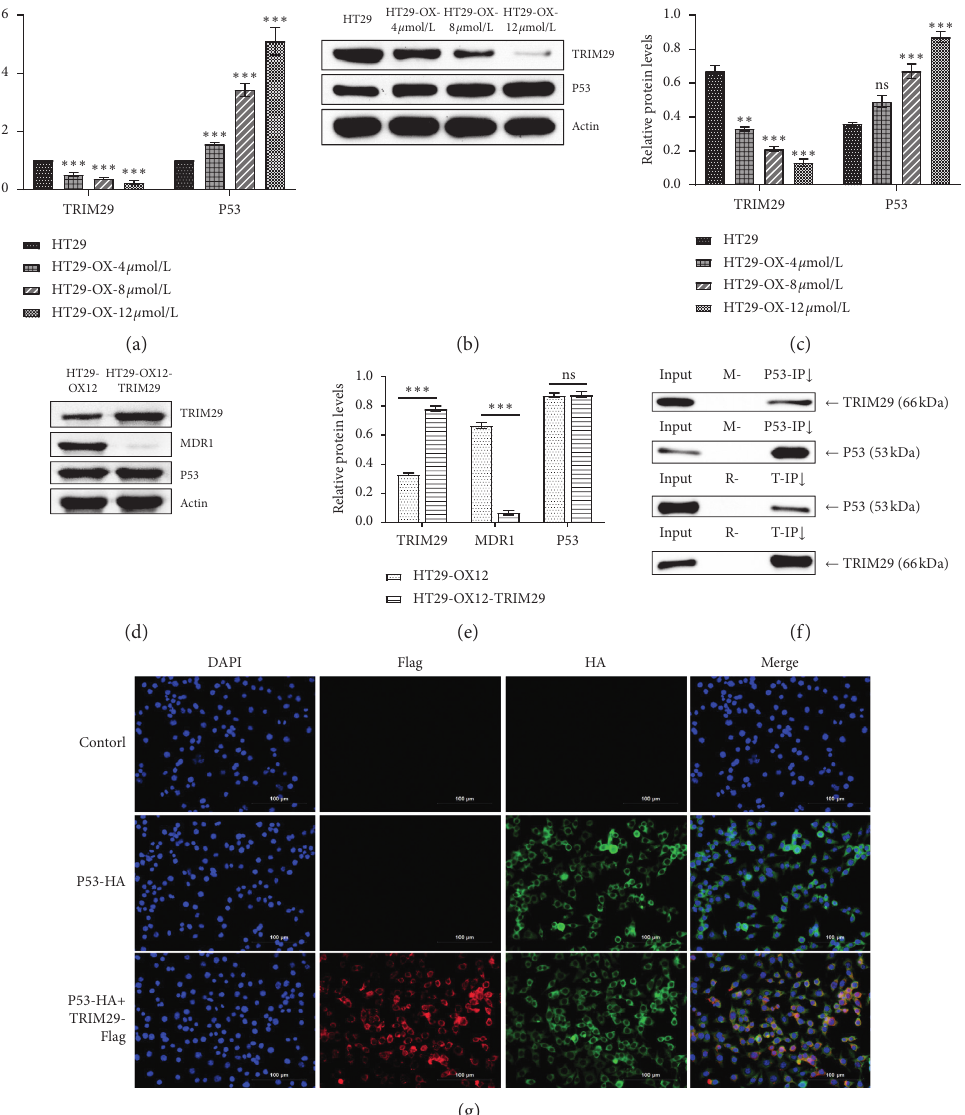
Figure 4: TRIM29 physically binds with mutant P53. (a) qRT-PCR was used to detect the expression of TRIM29 and P53 in the three drug- resistant cell models with the increase of drug resistance concentration. After the HT29-OX-12 μ mol/L cells were transfected with pIRES2- ZsGreen1-TRIM29-flag plasmid, the changes of P53 and MDR1 expression were detected. (b) The Western blot method was used to detect the expression of TRIM29 and P53 in the three drug-resistant cell models. (c) The quantitative analysis of (b). (d) After the HT29-OX- 12 μ mol/L cells were transfected with pIRES2-ZsGreen1-TRIM29-flag plasmid, the protein expression changes of P53 and MDR1 expression were detected. (e) Quantitative analysis of (d). (f) Coimmunoprecipitation method was used to detect the interaction between TRIM29 and mutant P53 protein in HT29 cells. (g) Immunofluorescence detection of the interaction between TRIM29 and mutant P53 protein in HT29 cells. Scale bar � 100 μ m. The magnification is 400 times; ns: not significant; ∗∗ P < 0 . 001; ∗∗∗ P < 0 . 001. The unpaired t -test was used to analyze comparisons between two groups, and comparisons among multiple groups were analyzed by one-way ANOVA, followed by Tukey’s post hoc